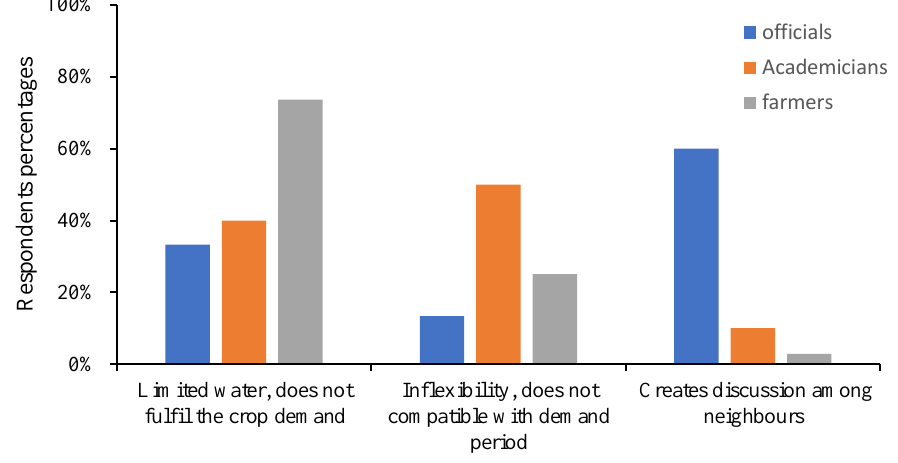
Figure 4. Responses from the farmers, academicians and officials on problems relevant to the Wara- bandi.